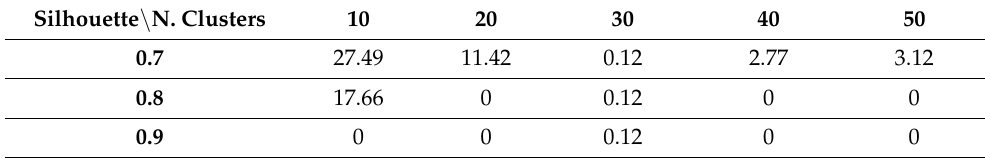
Table 16. Clustering performance in terms of silhouettes using normalized data. Silhouette \ N. Clusters